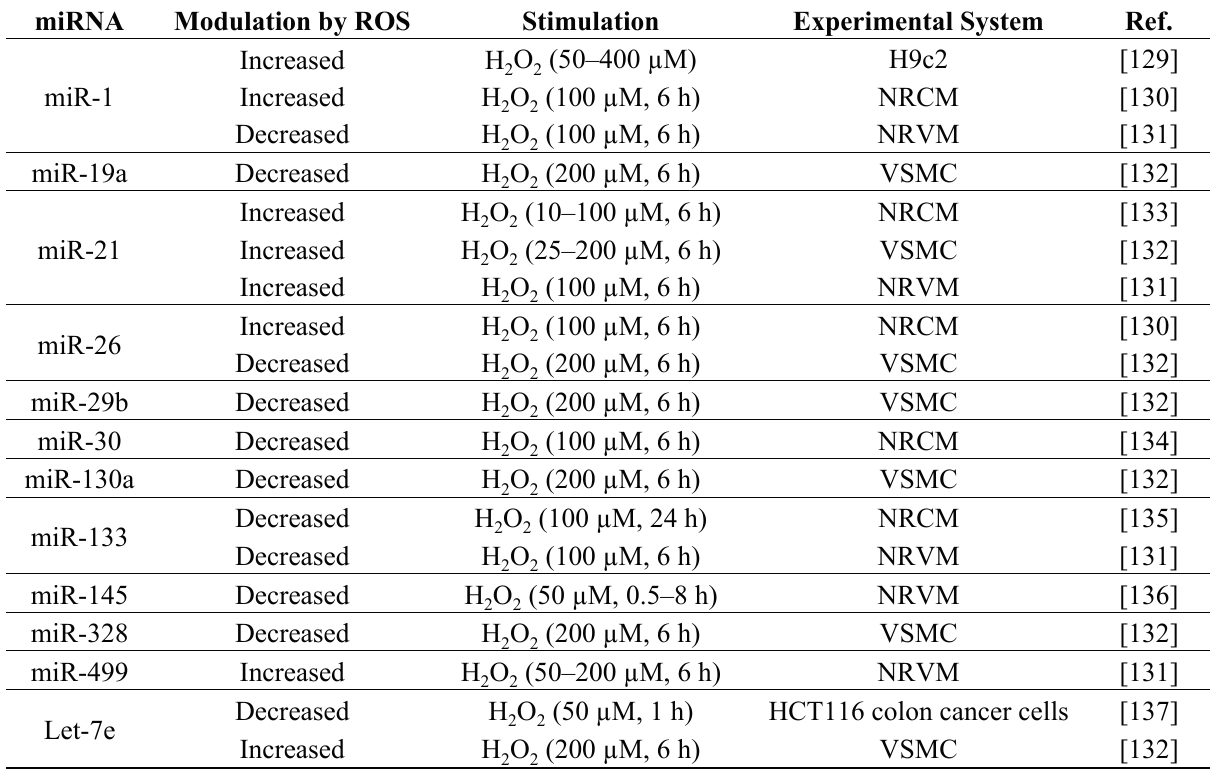
Table 2. Modulation of AF-related miRNAs by